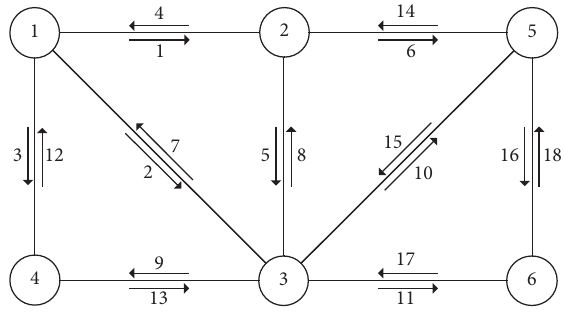
Figure 1: Elementary example